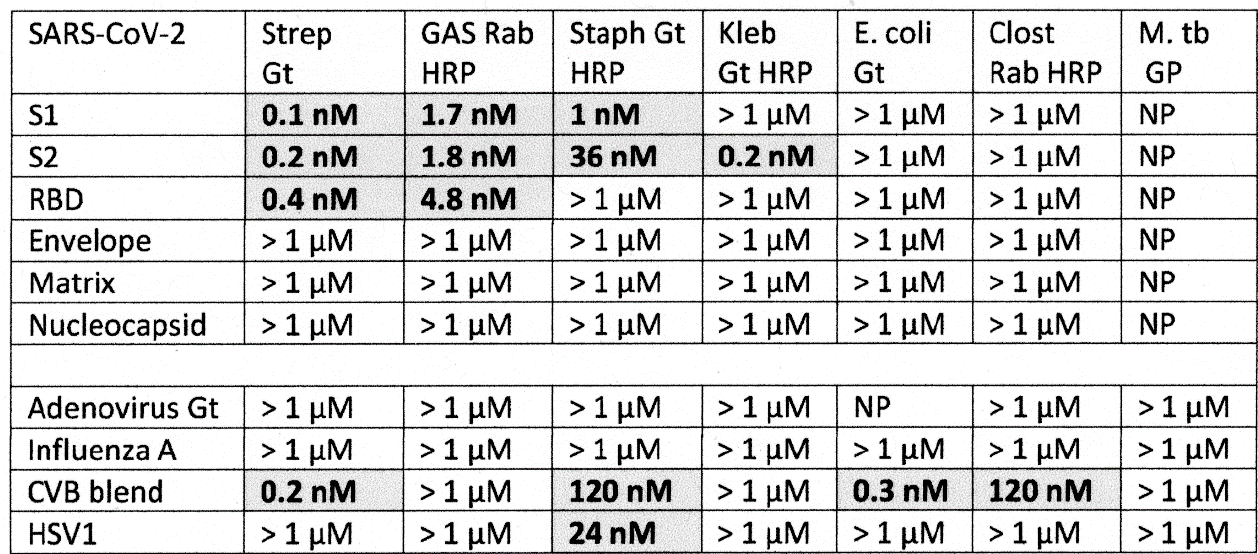
Figure 11. Results of double-antibody ELISA (DA-ELISA) experiments testing whether polyclonal antibodies against viruses recognized polyclonal antibodies against bacteria as “antigens”. Significant binding affinities (K D 100 nM or smaller) are bolded against a grey background. NP = not possible to run the experiment because it was found that anti-rabbit horse-radish-peroxidase-labelled (HRP) antibodies recognized guinea pig antibodies and anti-guinea-pig-HRP antibodies recognized rabbit antibodies. S1, is a mixture of coxsackievirus type B antibodies; HSV1 = human herpes simplex type 1 antibodies.